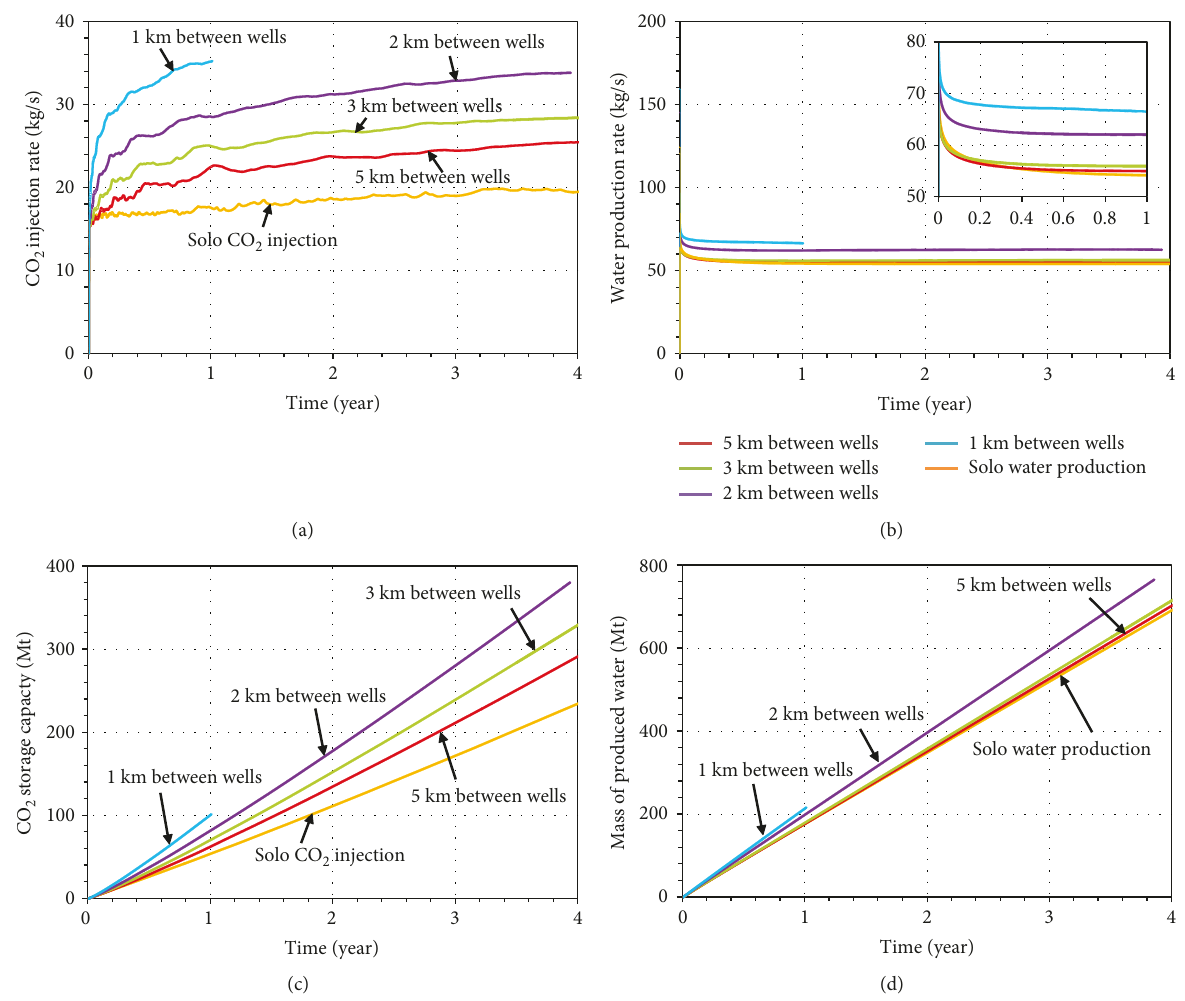
Figure 8: The e ff ect of the well spacing on the CO Injection and production